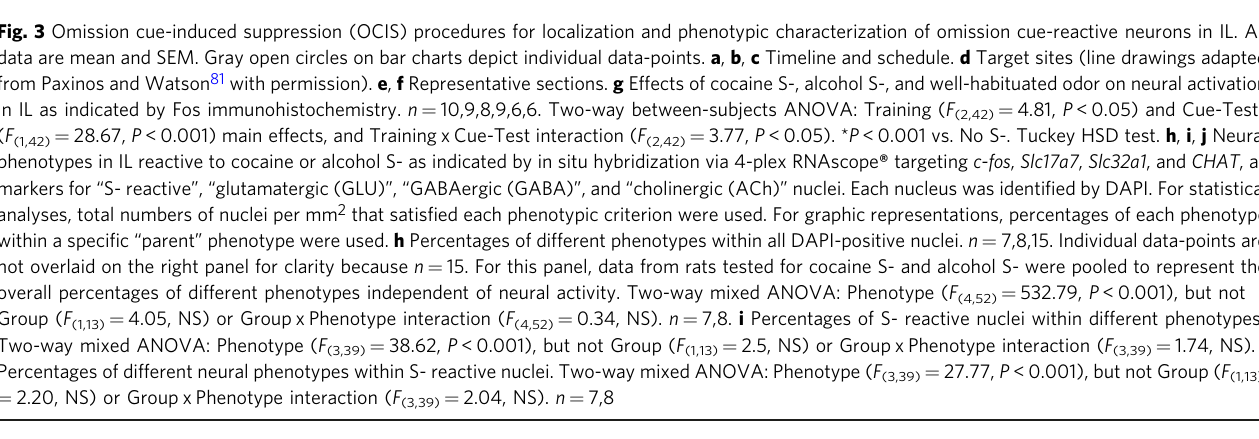
Fig. 3 Omission cue-induced suppression (OCIS) procedures for localization and phenotypic characterization of omission cue-reactive neurons in IL. All data are mean and SEM. Gray open circles on bar charts depict individual data-points. a , b , c Timeline and schedule. d Target sites (line drawings adapted from Paxinos and Watson 81 with permission). e , f Representative sections. g Effects of cocaine S-, alcohol S-, and well-habituated odor on neural activation in IL as indicated by Fos immunohistochemistry. n = 10,9,8,9,6,6. Two-way between-subjects ANOVA: Training ( F (2,42) = 4.81, P < 0.05) and Cue-Test ( F (1,42) = 28.67, P < 0.001) main effects, and Training x Cue-Test interaction ( F (2,42) = 3.77, P < 0.05). * P < 0.001 vs. No S-. Tuckey HSD test. h , i , j Neural phenotypes in IL reactive to cocaine or alcohol S- as indicated by in situ hybridization via 4-plex RNAscope ® targeting c-fos , Slc17a7 , Slc32a1 , and CHAT , as markers for “ S- reactive ” , “ glutamatergic (GLU) ” , “ GABAergic (GABA) ” , and “ cholinergic (ACh) ” nuclei. Each nucleus was identi fi ed by DAPI. For statistical analyses, total numbers of nuclei per mm 2 that satis fi ed each phenotypic criterion were used. For graphic representations, percentages of each phenotype within a speci fi c “ parent ” phenotype were used. h Percentages of different phenotypes within all DAPI-positive nuclei. n = 7,8,15. Individual data-points are not overlaid on the right panel for clarity because n = 15. For this panel, data from rats tested for cocaine S- and alcohol S- were pooled to represent the overall percentages of different phenotypes independent of neural activity. Two-way mixed ANOVA: Phenotype ( F (4,52) = 532.79, P < 0.001), but not Group ( F (1,13) = 4.05, NS) or Group x Phenotype interaction ( F (4,52) = 0.34, NS). n = 7,8. i Percentages of S- reactive nuclei within different phenotypes. Two-way mixed ANOVA: Phenotype ( F (3,39) = 38.62, P < 0.001), but not Group ( F (1,13) = 2.5, NS) or Group x Phenotype interaction ( F (3,39) = 1.74, NS). j Percentages of different neural phenotypes within S- reactive nuclei. Two-way mixed ANOVA: Phenotype ( F (3,39) = 27.77, P < 0.001), but not Group ( F (1,13)